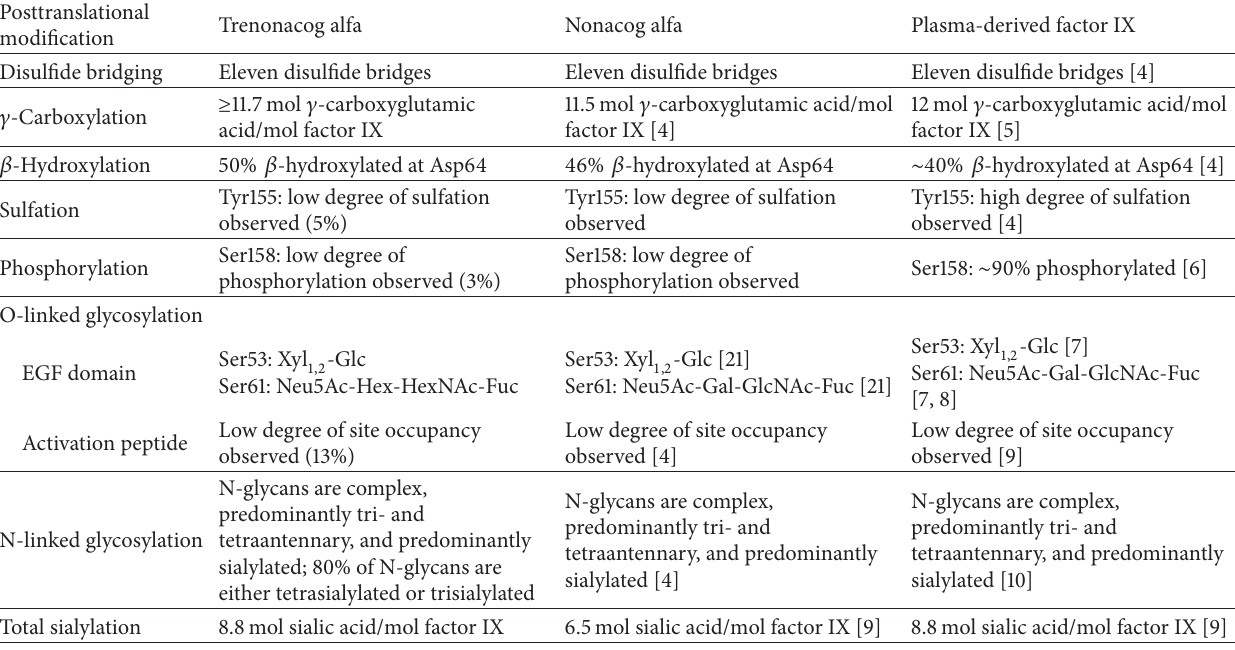
Table 1: Posttranslational modifications in trenonacog alfa, nonacog alfa, and plasma-derived factor IX.